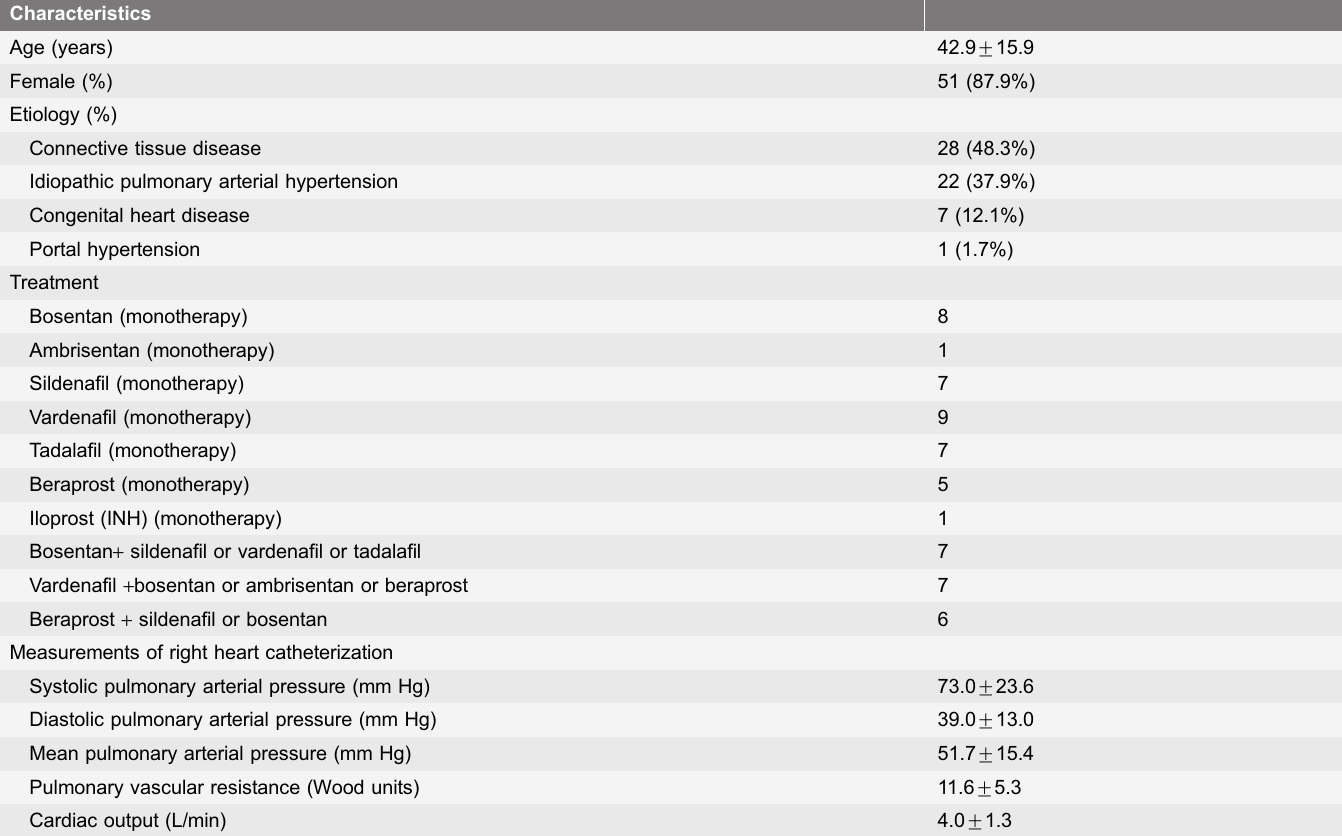
Table 1. Baseline demographic and clinical characteristics in all